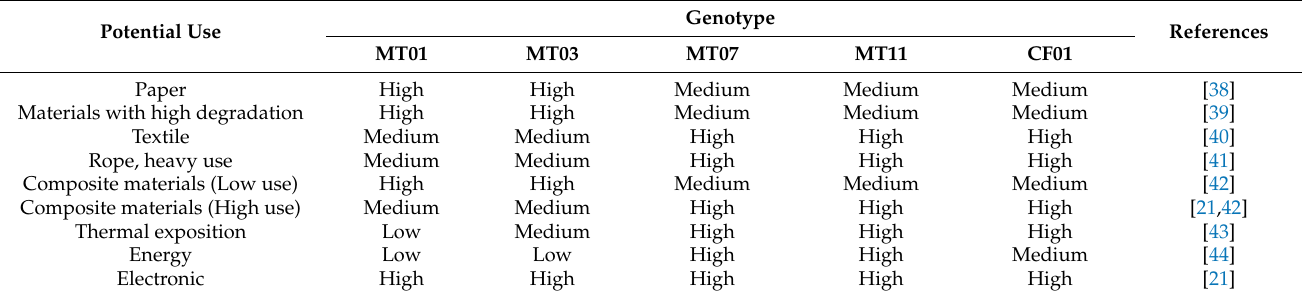
Table 3. Potential uses for M. textilis fibers of each